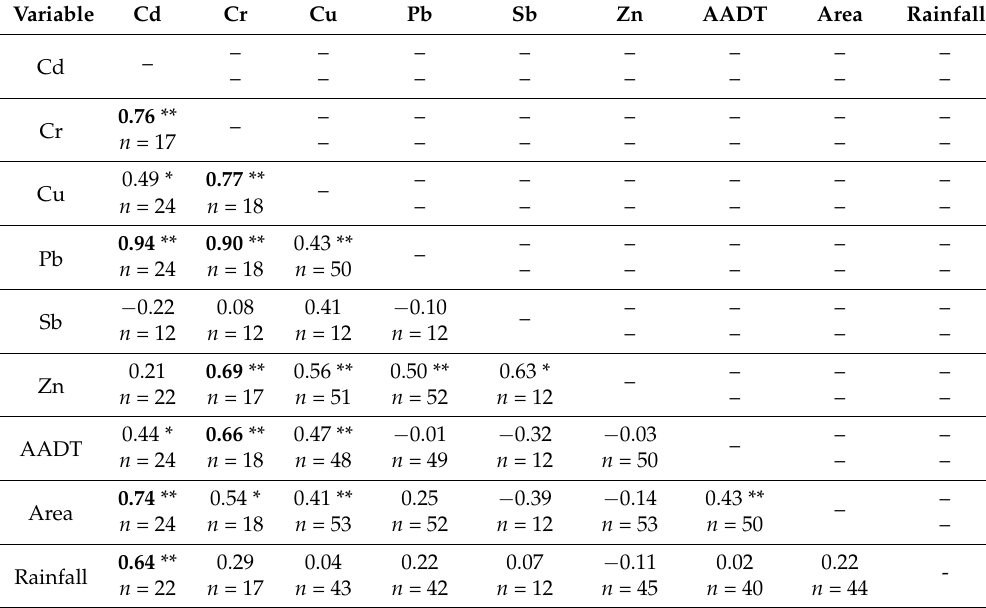
Table 3. Spearman correlation coefficients of average annual daily traffic (AADT), catchment area, annual rainfall depths, and heavy metal runoff loads: correlation coefficient ď 0.39 = weak correlation, 0.40–0.59 = medium correlation, and ě 0.60 = strong correlation. Strong correlations are in bold type and no values are presented for Ni because of the small n (5 or 6 for all